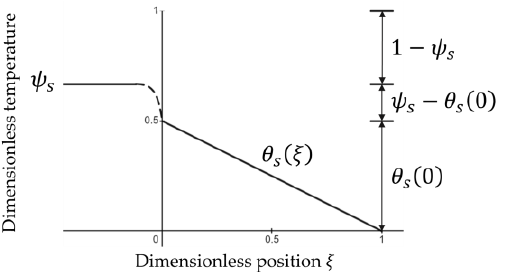
≡ 1, Bi = 3, and t a / t c =